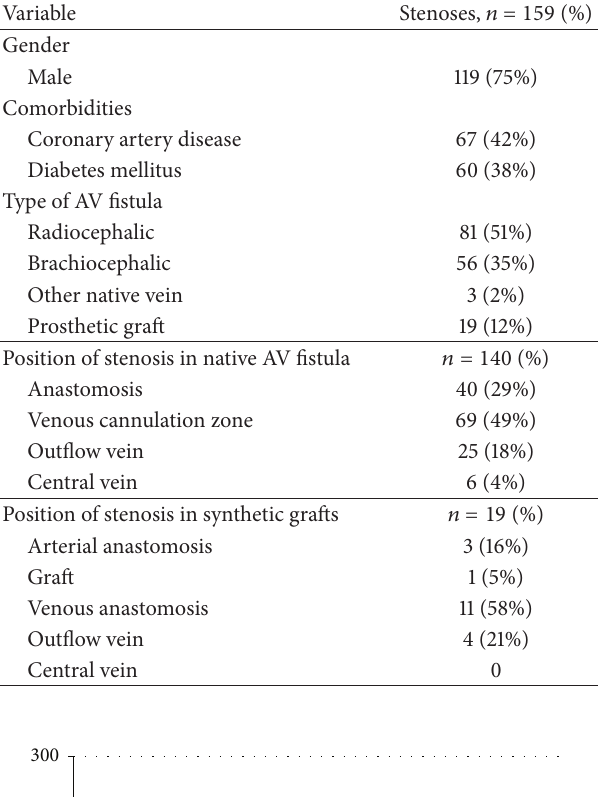
Table 1: Baseline clinical characteristics.